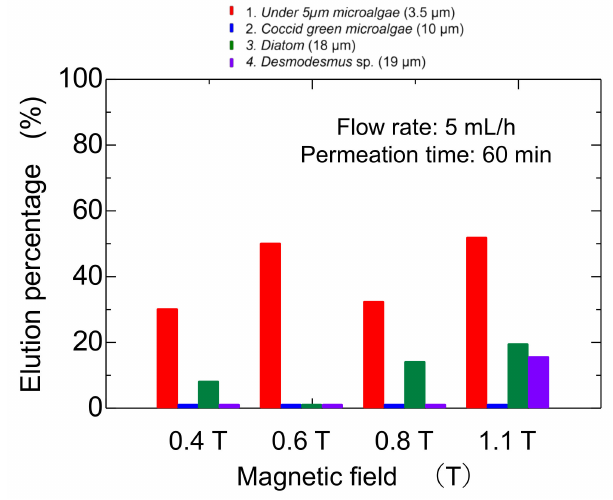
Figure 6. Elution percentage of microalgae at various static magnetic fields.